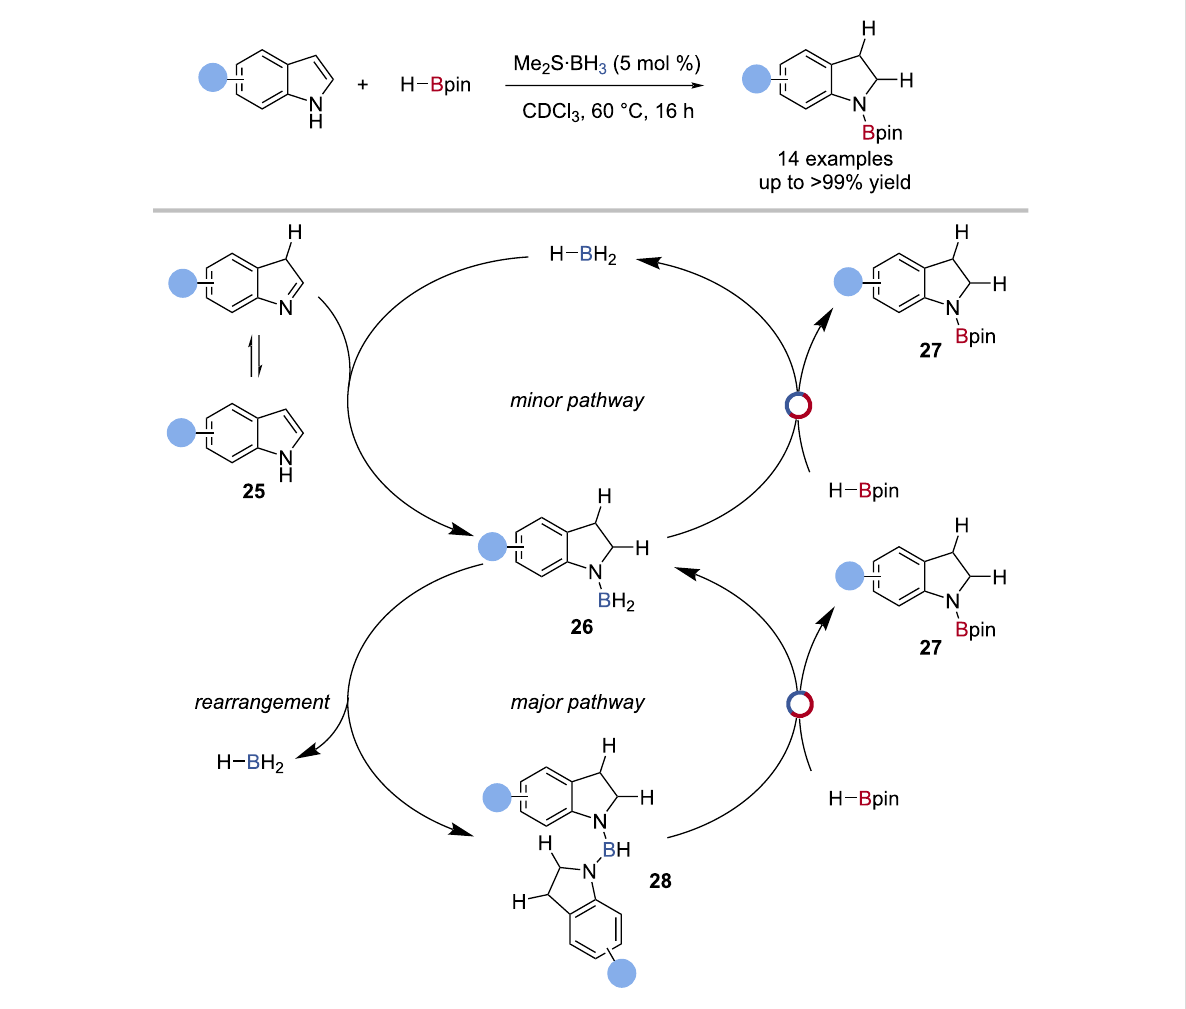
Scheme 7: Borane-catalysed reduction of indoles and the proposed